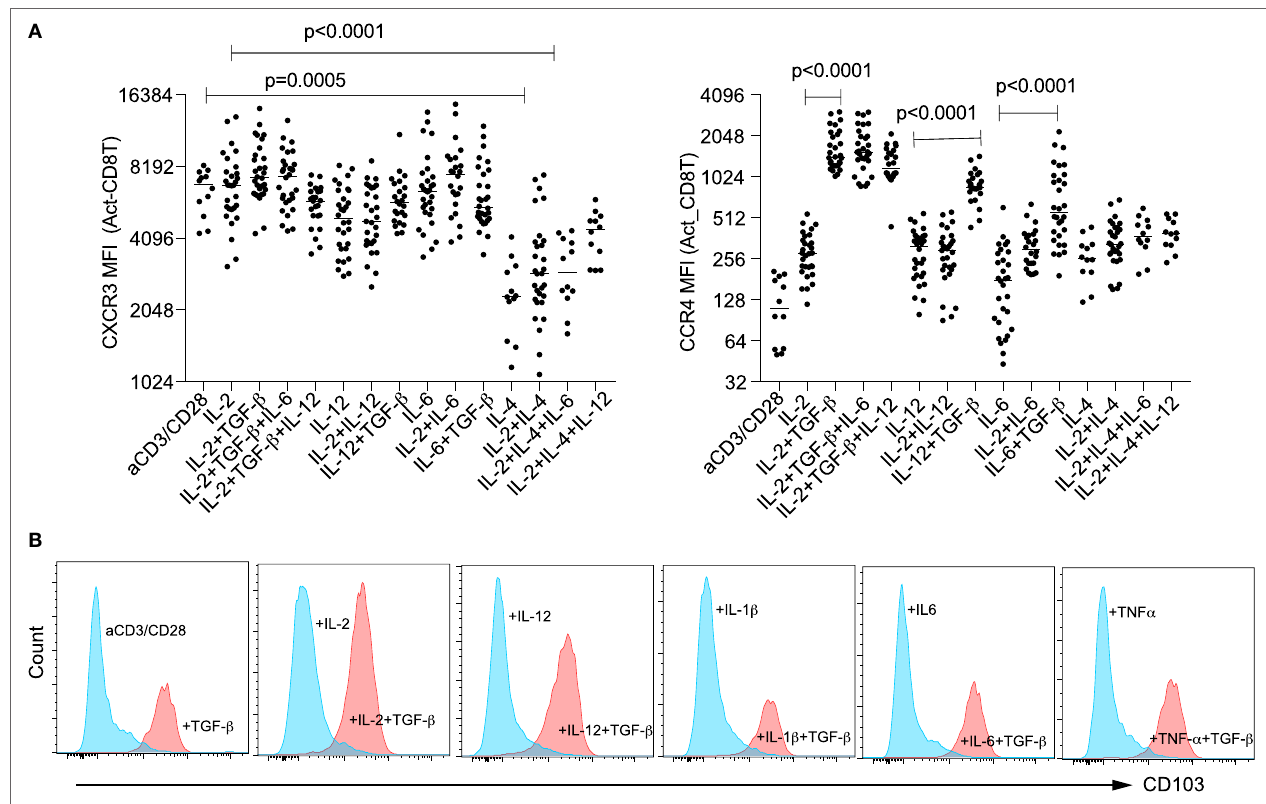
FigUre 3 | TGF- β induces expression of mucosa-chemotactic molecules on CD8 + T cells. Surface expression of chemokine receptors CXCR3 and CCR4 (a) and integrin CD103 (B) 4 days after activation of naïve CD8 + T cells under specified conditions (data are representative of n > 10 donors). P -values between indicated groups were calculated on matched pairs by Wilcoxon matched-pairs signed